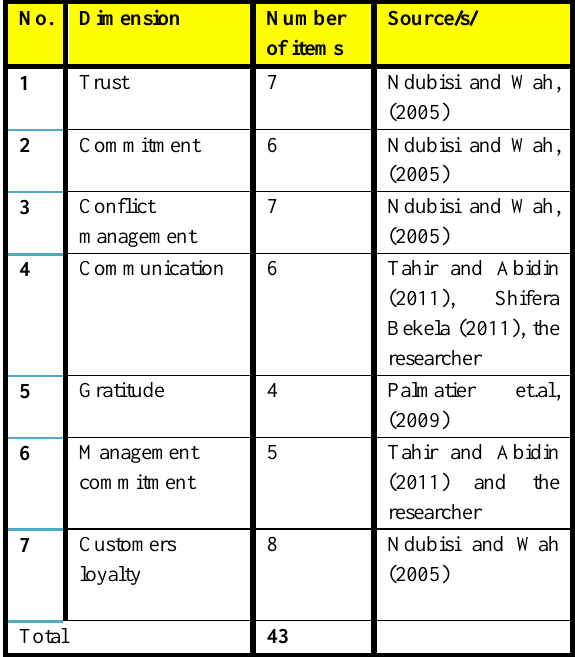
Table 1: Summary of questionnaire and its sources No.